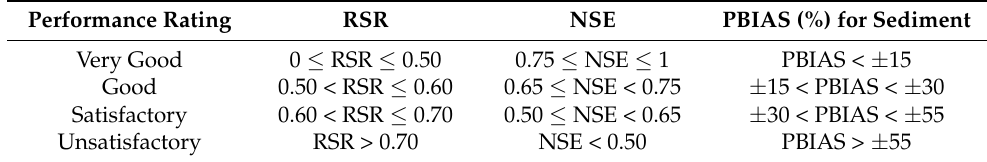
Table 2. General performance ratings [49].